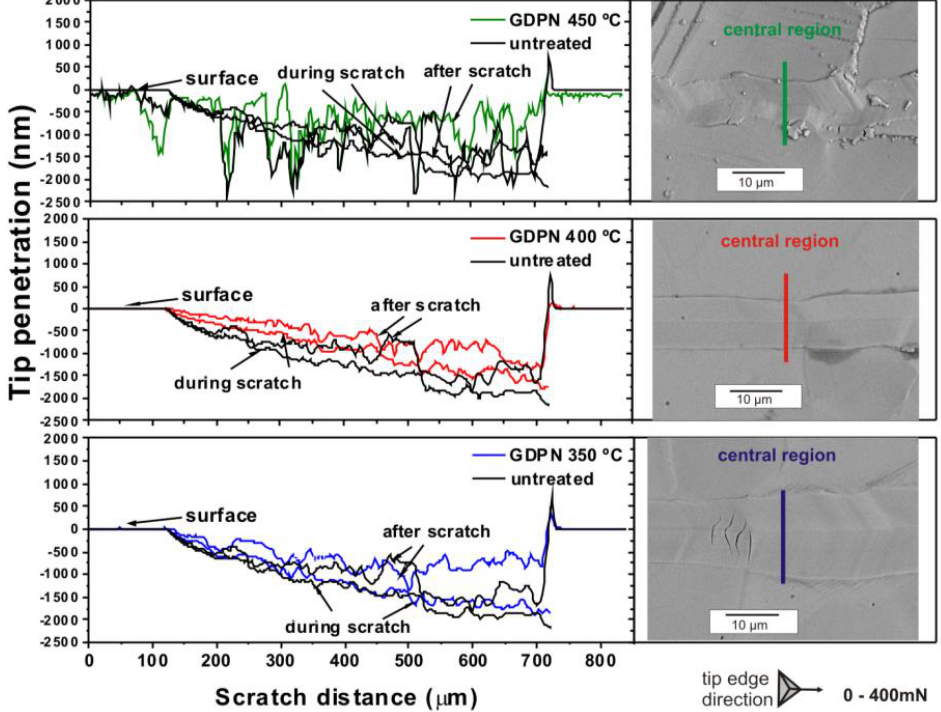
Figure 13. Hardness profiles of the CCPN 450 °C sample in the film and the region below the de-